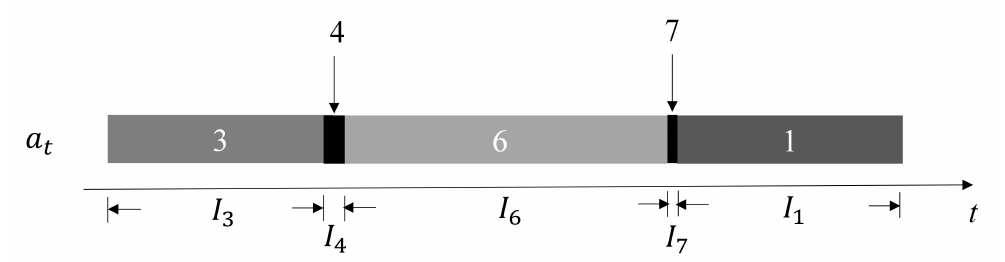
Figure 3. An example of mapping from path A = { a 1 ,..., a T } to final classification outcome R = { r 1 , r 2 , r 3 } for the recognition of three gestures (i.e., K = 3). In this example, r 1 = 3, r 2 = 6, and r 3 =